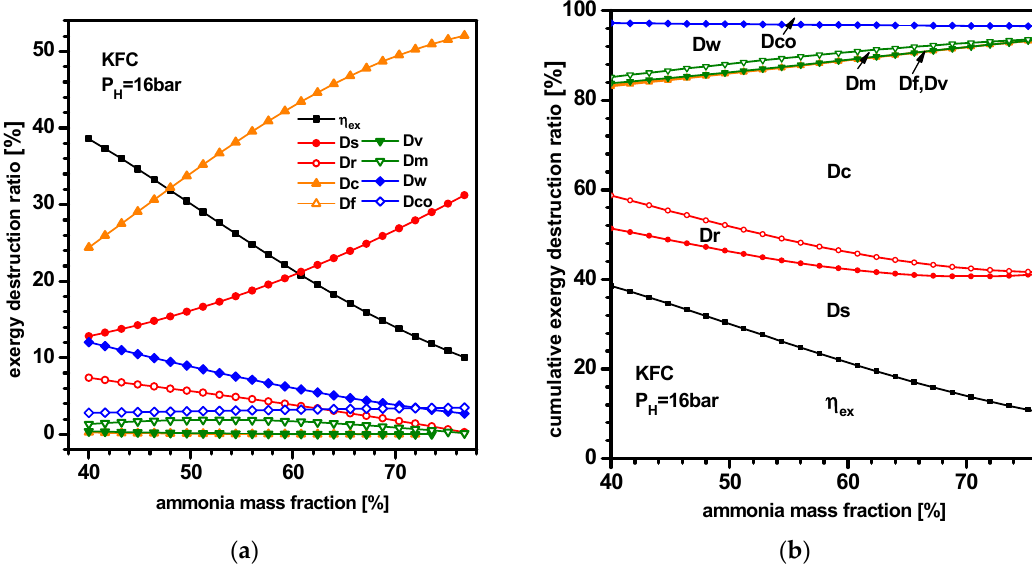
Figure 11. Dependence of ( a ) separate and ( b ) cumulative ratios of exergy consumption on the ammonia mass fraction for P H = 16 bar in the KFC.